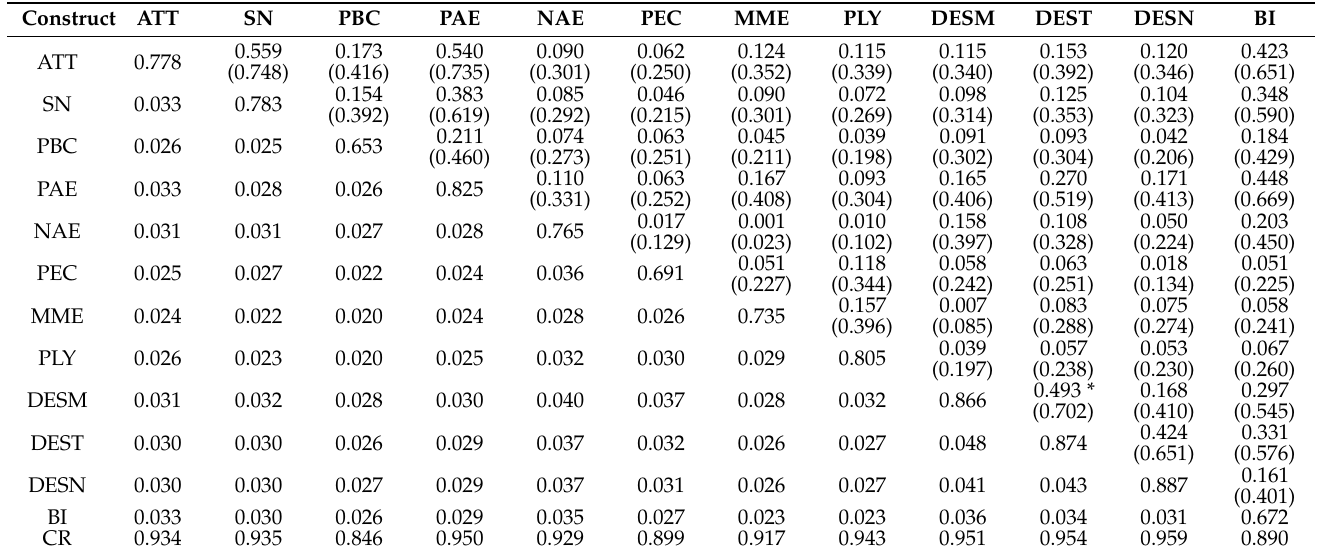
Table 4. Results of measurement model (N = 711).